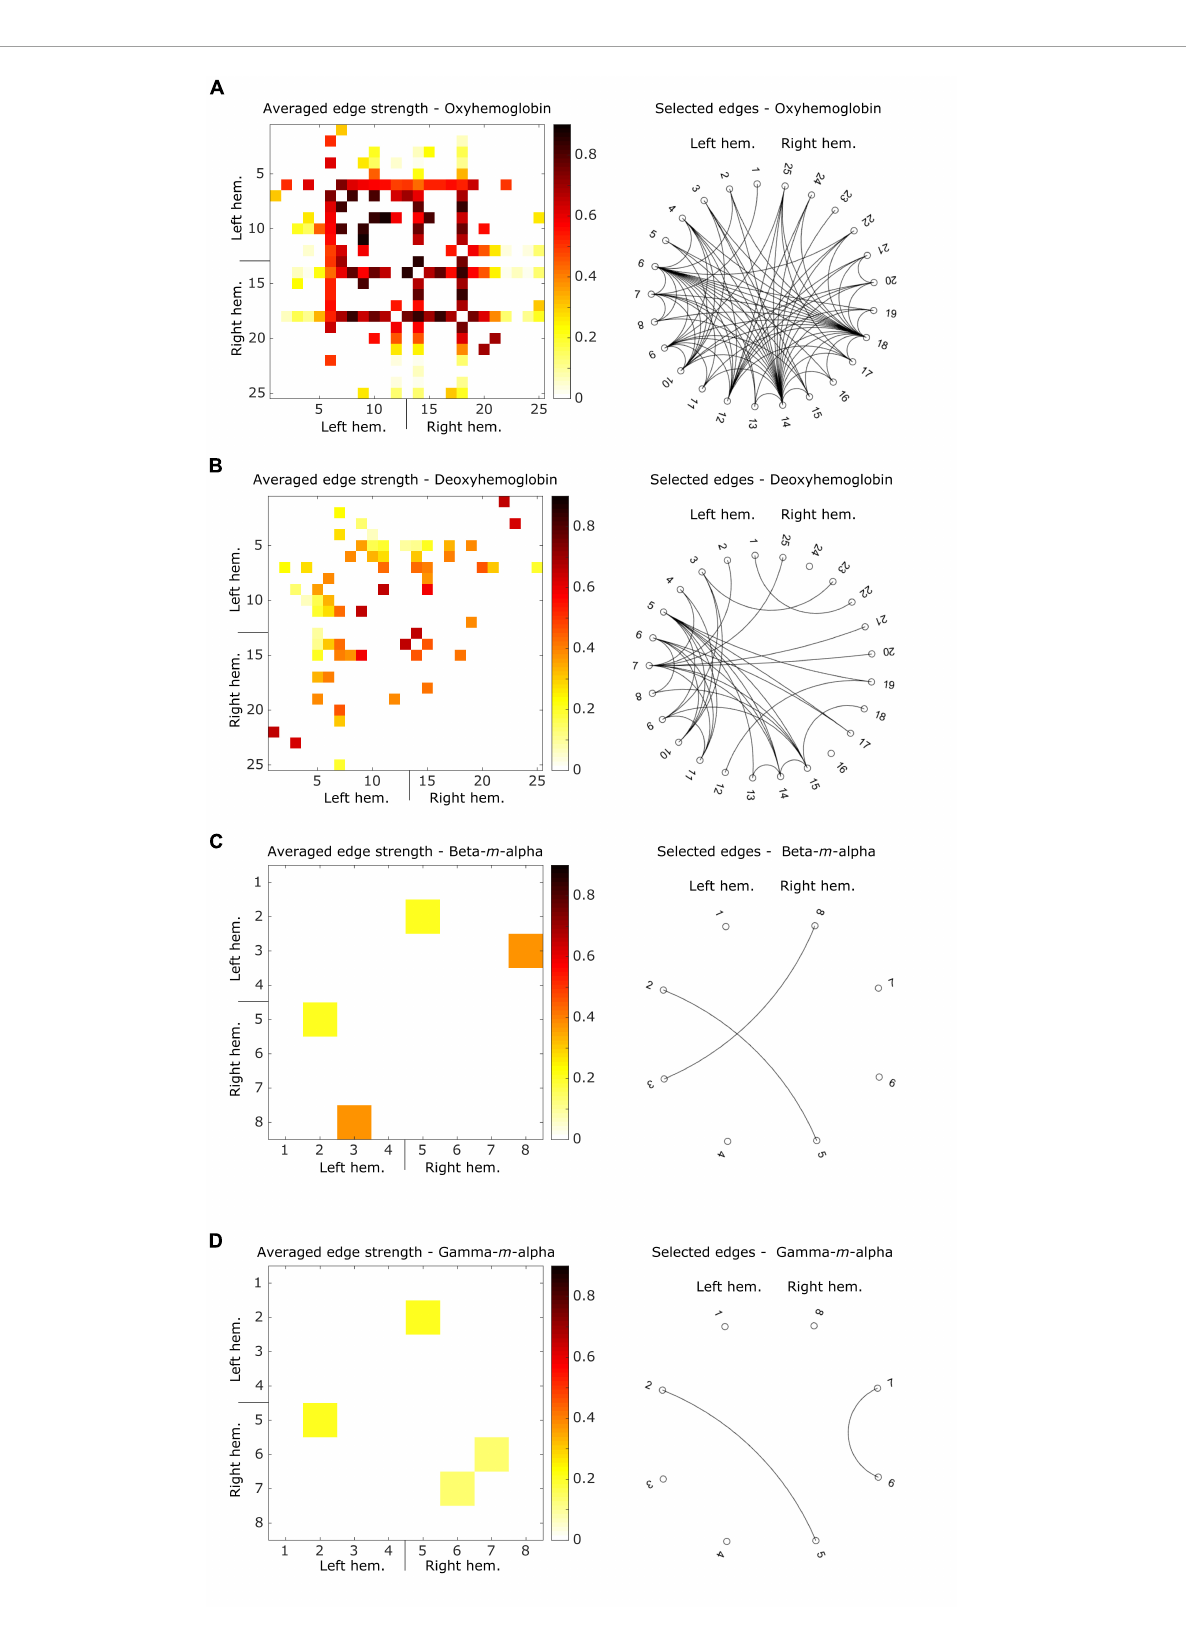
FIGURE4 Averaged connectivity matrices showing the strength of the selected edges, and ring graphs describing the binary connections resulting from these edges for (A) oxyhemoglobin, (B) deoxyhemoglobin, (C) beta- m -alpha, (D) gamma- m -alpha. For connectivity matrices, hotter colors represent strong connectivity, while white squares represent connections removed by the correlation-based mask. For ring graphs, each black line represents a binary connection between two